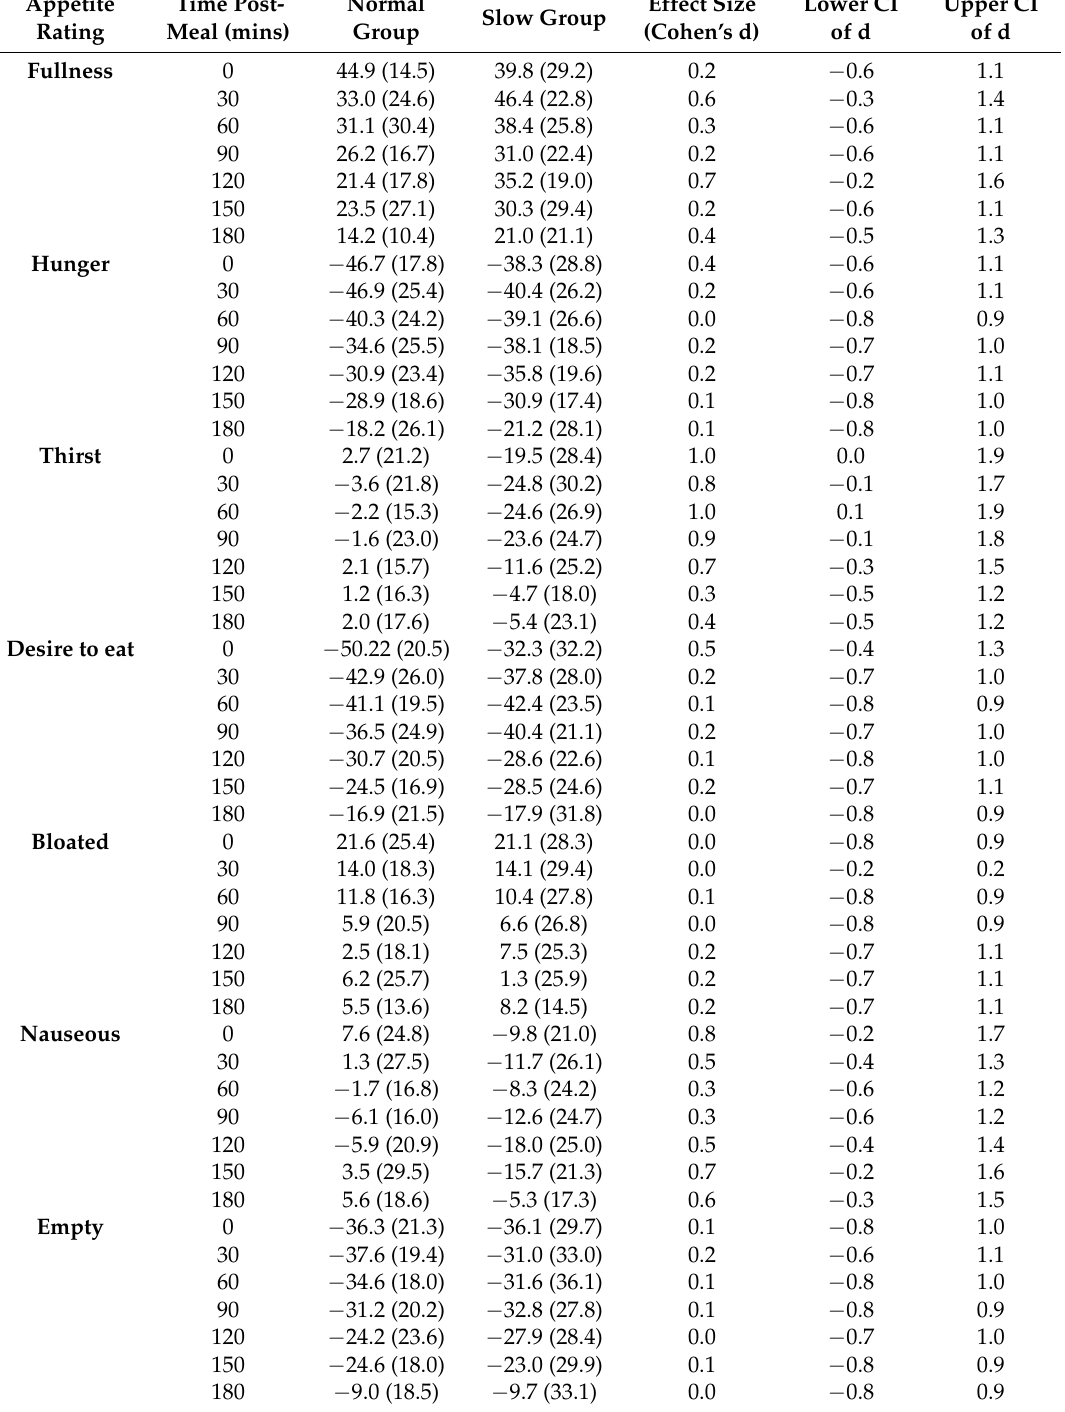
Table A3. Changes in mean (s.d.) appetite ratings from baseline immediately